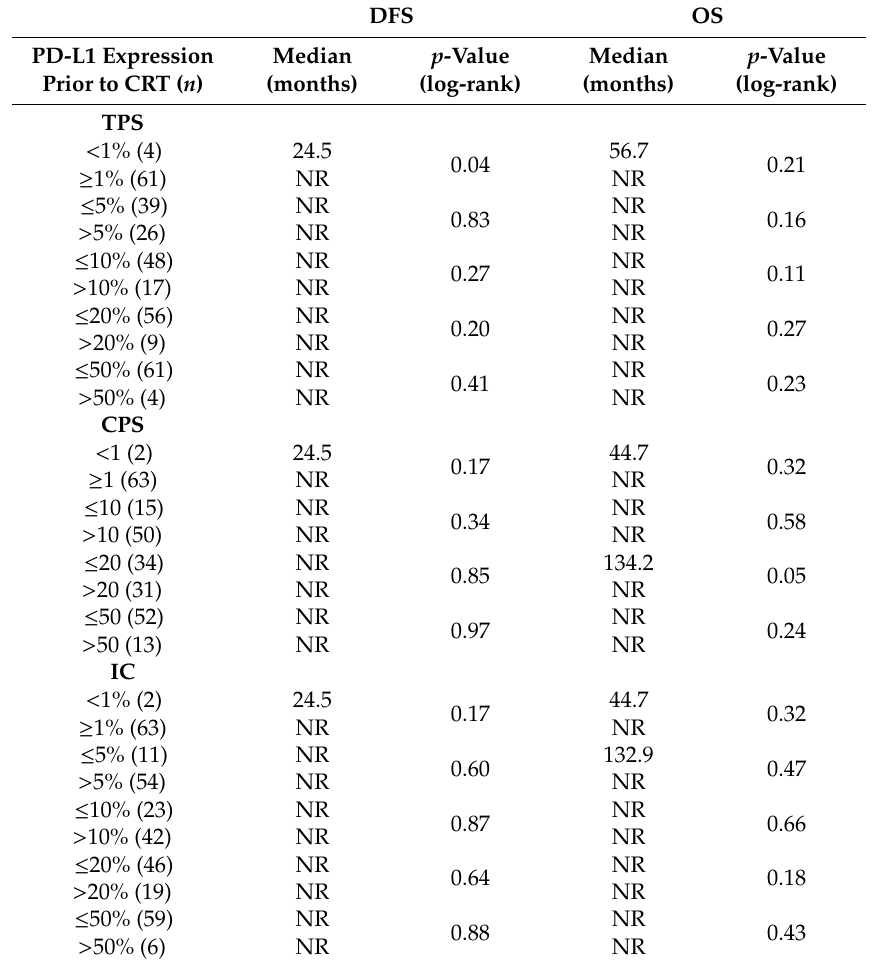
Table A1. DFS and OS according to established PD-L1 cut-o ff values. DFS